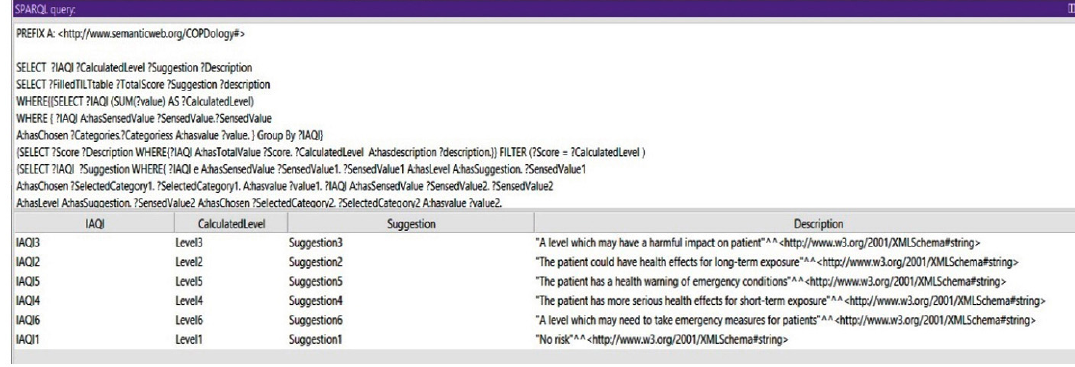
Figure 18. Query 2 and result.